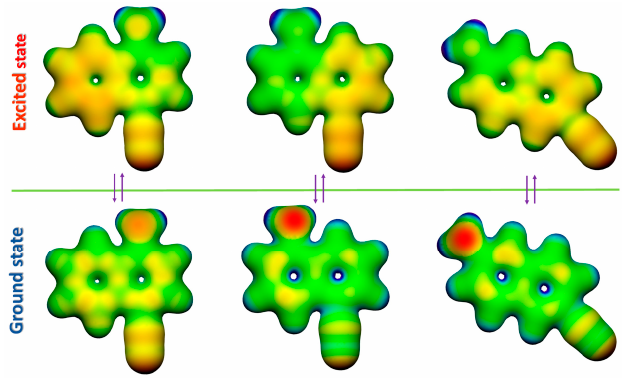
Figure 5. Electrostatic potentials (ESP) for the relaxed ground and excited states of the 1,4-ICAN, 1,5-ICAN, and 2,6-ICAN isomer (from left to right).